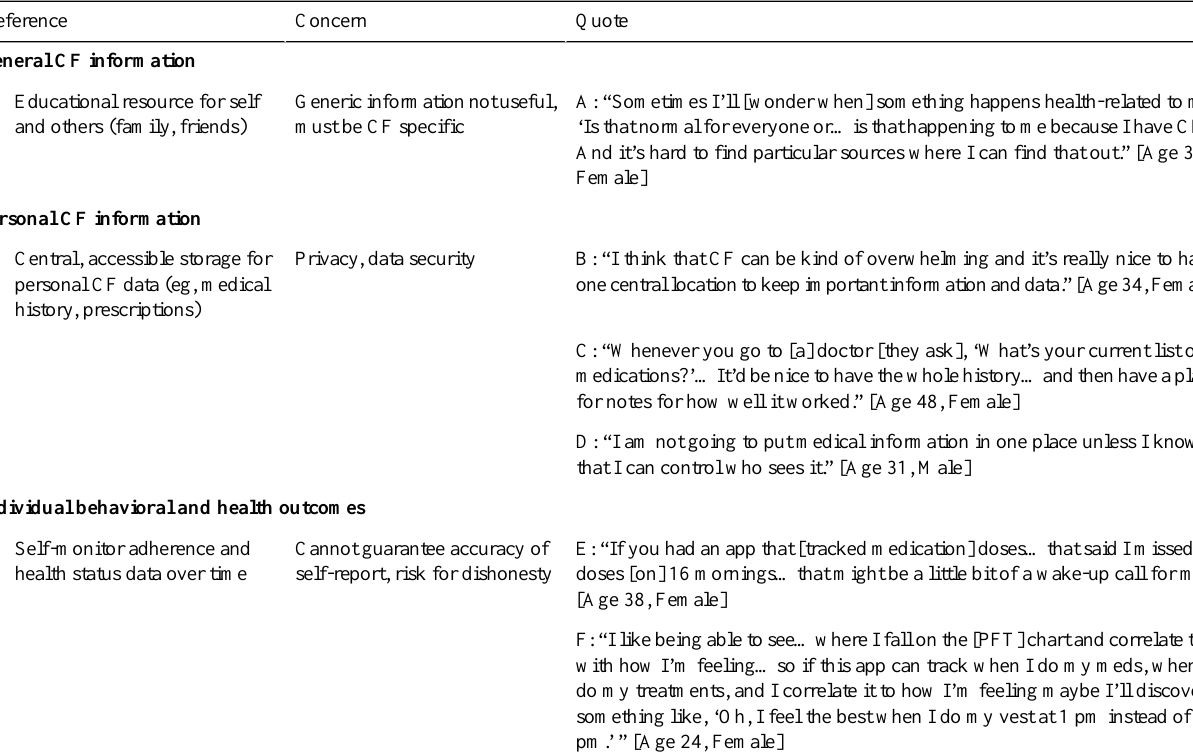
Table 2. Participant preferences, concerns, and illustrative quotes regarding Information at One’s Fingertips